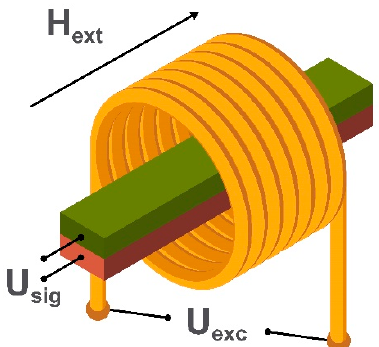
Figure 6. Schematic image of the sensing element of a magnetoelectric magnetometer, where H ext is the applied external magnetic field, and U exc is the voltage generating an external excitation magnetic field. U sig is the voltage produced by the piezoelectric material which is deposited onto a magnetostrictive ferromagnetic material.